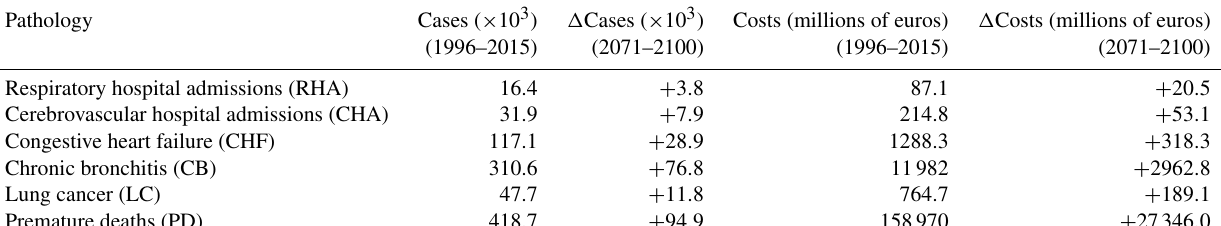
Table 3. Mean number of cases (in miles of cases) as associated costs (in millions of euros) per year for each pathology for present climate